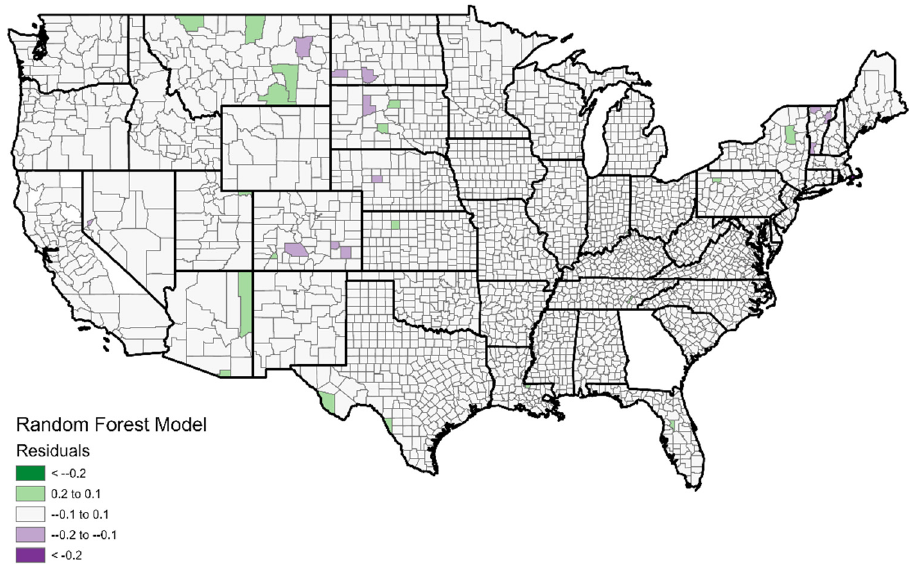
Figure 8. Residuals from random forest model. Green indicates vaccination rates were higher than expected; purple indicates vaccination rates were lower than expected. Note that the predictions are much more accurate in general than those of the logistic regression model.